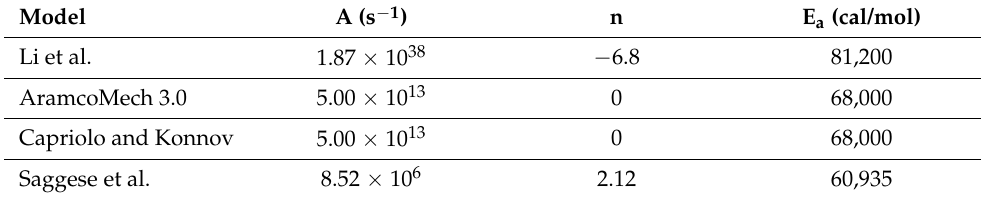
Table 3. Reaction rates for (R1) from each of the four kinetics mechanisms investigated herein.